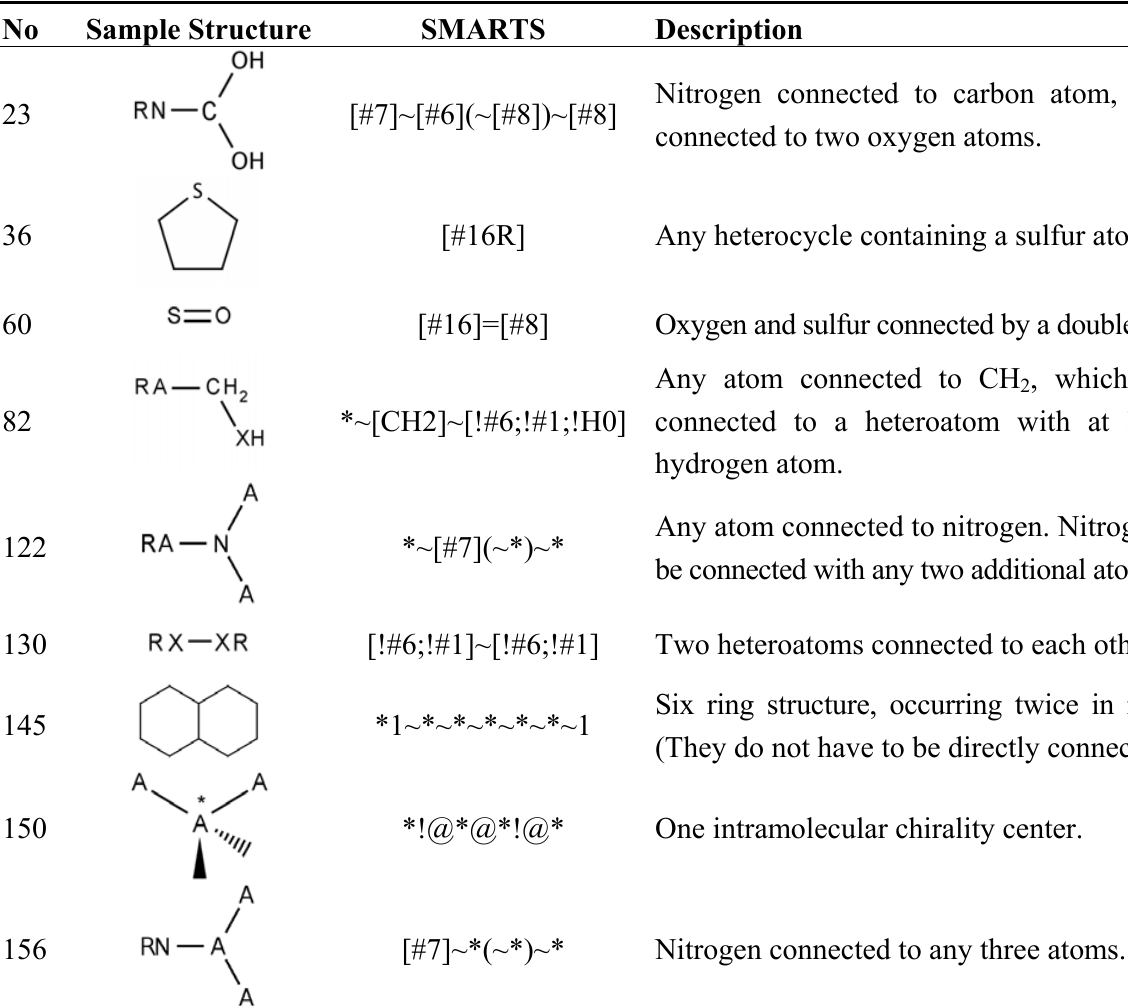
Table 4. Fingerprints selected from the MACCS keys are given along with their internal number (No), SMARTS code, and a short explanation of the substructure. In the sample structure, “A” stands for any atom, “X” for a heteroatom, and “R” for any molecular